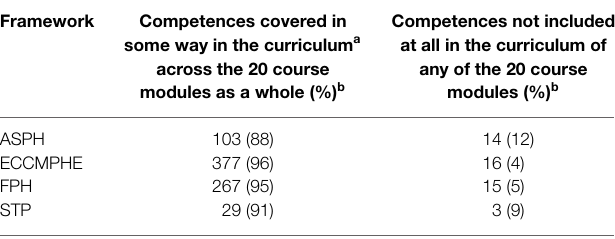
TABLE 3 | The number (%) of competences included in the curriculum across all 20 course modules available . Framework